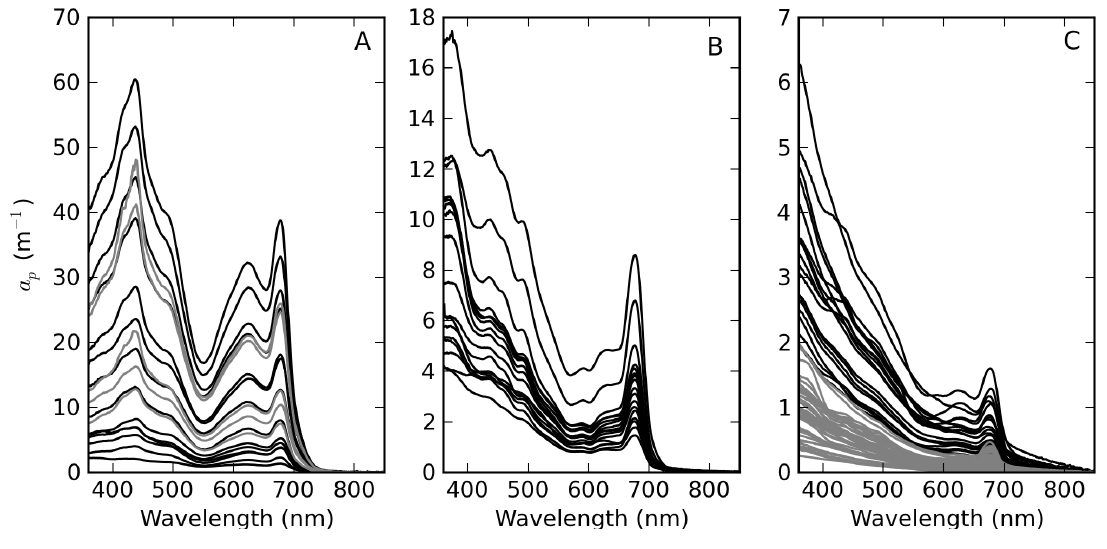
Figure 5. a spectra measured in ( A ) Hartbeespoort (gray lines scaled by 0.1 to facilitate p comparison), ( B ) Loskop for a (442) > 2 m − 1 and ( C ) Theewaterskloof (black lines) and p Loskop for a (442) < 2 m − 1 (gray p